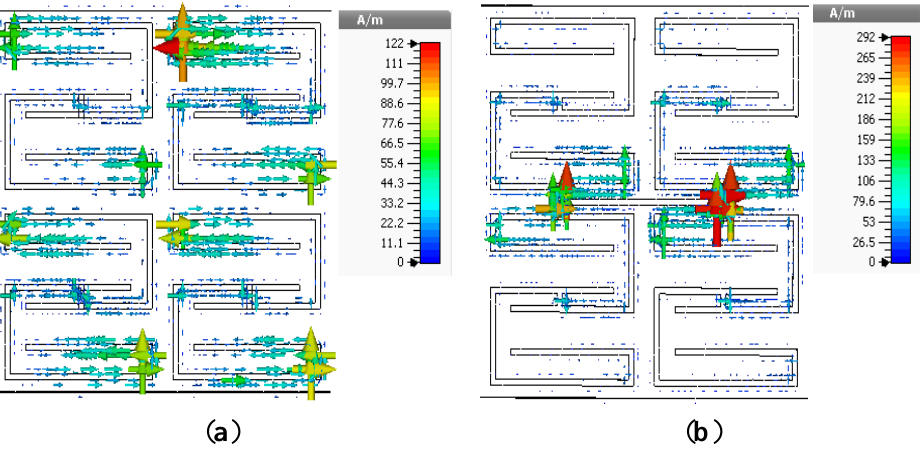
Figure 9. Surface current distributions of 2 × 2 array of unit cell B at 3.5 GHz: ( a ) open array and ( b ) interconnected